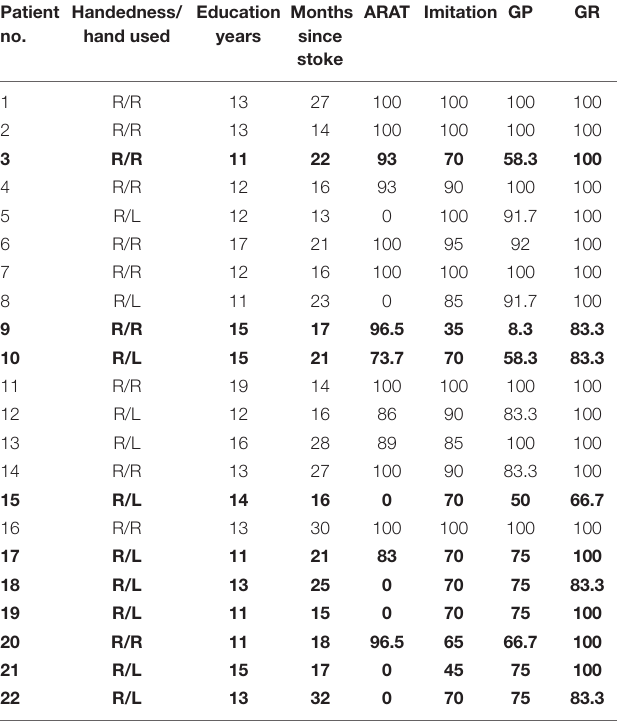
TABLE 1 | Patient